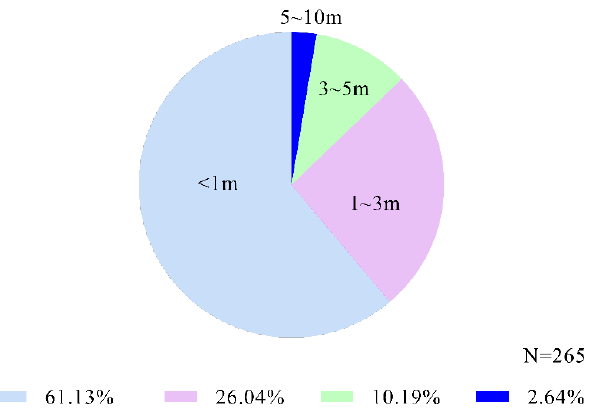
Figure 3. Distribution of scratch contagion at different distances.